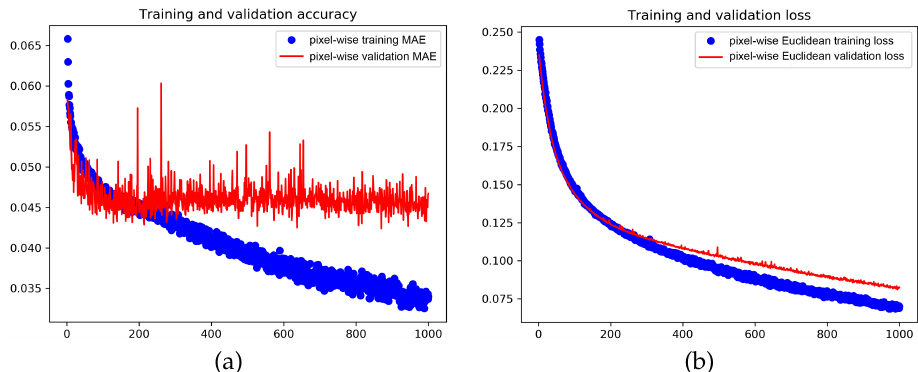
Figure 13. Learning and convergence rate, and loss of CSRNet with a dilation rate of 2 in the backbone. Here, all 16.2 million parameters are adjusted at once using the Adam optimizer. ( a ) The pixel-wise MAE is shown over 1000 epochs for the training set (blue) and the validation set (red). ( b ) The training and the validation Euclidean losses are shown over 1000 epochs.